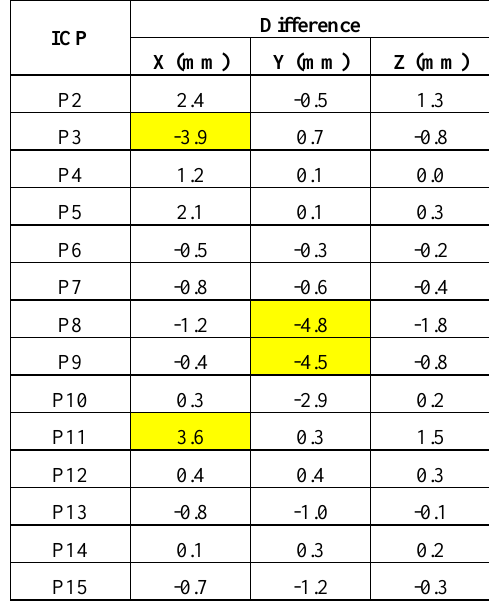
Table 5. Results of SF6 GIL coordinates in session 1